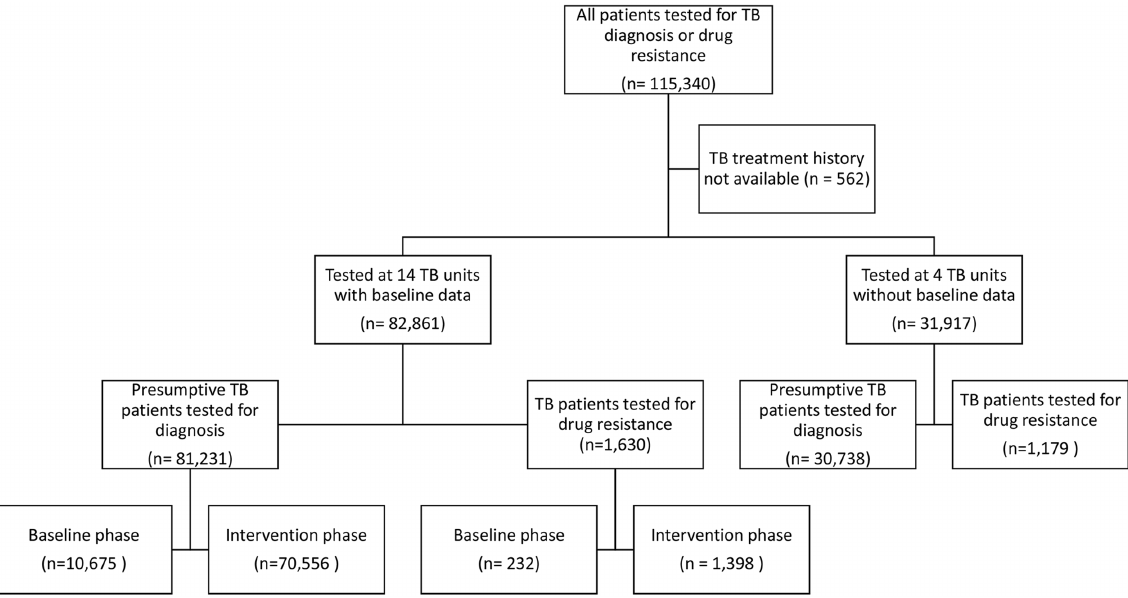
Fig 2. Enrollment of presumptive tuberculosis and drug resistant tuberculosis cases in baseline and intervention period of the